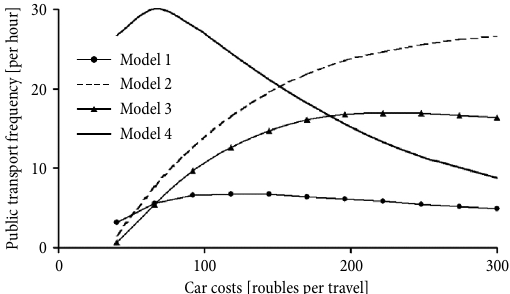
Fig. 3. Influence of value of time on probability of car use